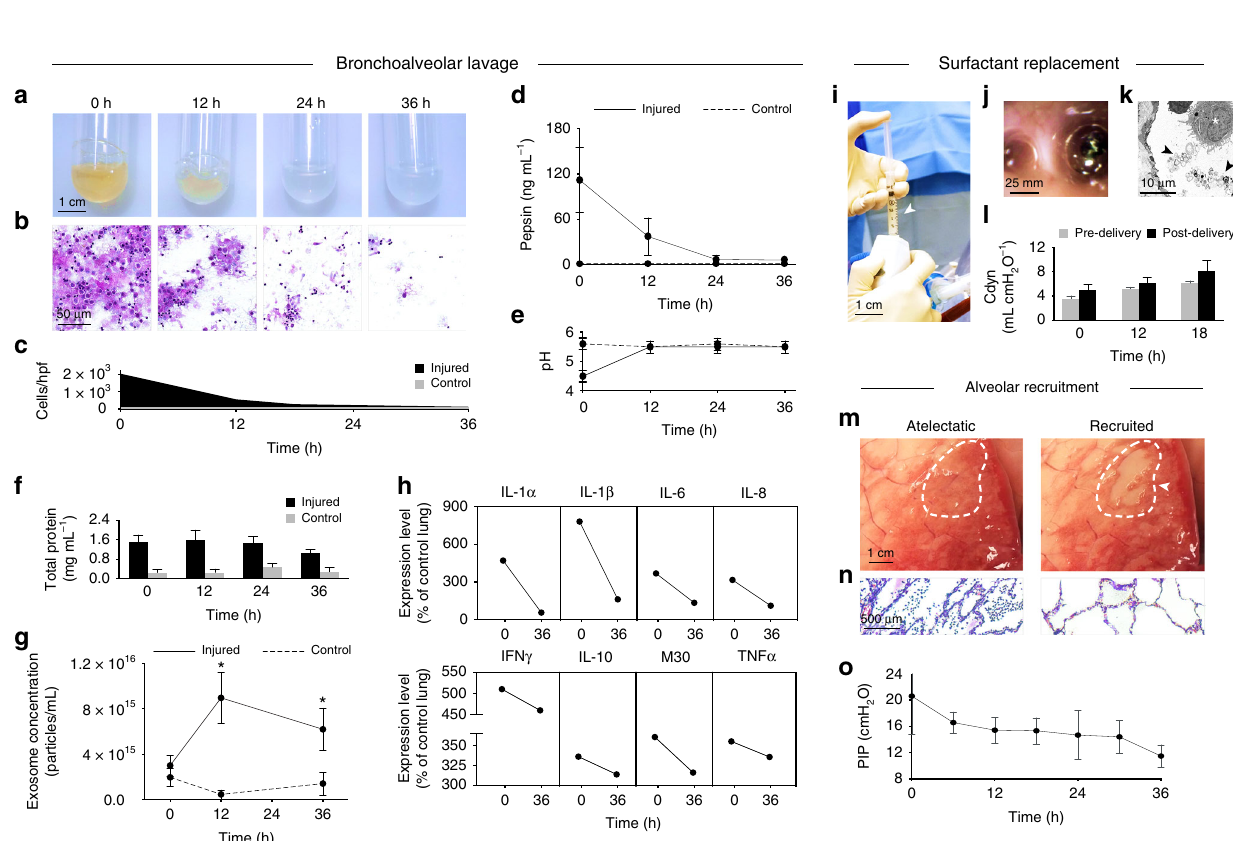
Fig. 3 Therapeutic interventions in injured lungs during cross-circulation. a Gross imaging of BAL fl uid samples collected from injured lungs over 36 h of cross-circulation. b Periodic acid-Schiff staining of BAL fl uid smears obtained from injured lungs. c Quanti fi cation of cells in BAL fl uid samples. d Pepsin concentration, e pH, f total protein, and g exosome concentration in BAL fl uid samples over 36 h of cross-circulation, Student ’ s t -test for Injured versus Control, * p < 0.001. h Mean cytokine expression levels in injured lungs, normalized as a percent of mean levels in control lungs, measured in BAL fl uid between initiation of cross-circulation (0 h) and conclusion of cross-circulation (36 h). Cytokine concentrations (mean ± standard deviation) throughout 36 h of cross-circulation in Supplementary Fig. 5c. Surfactant replacement: i Bronchoscopic delivery of therapeutic surfactant into injured lung (arrow). j Bronchoscopic image demonstrating therapeutic surfactant delivered into airways within the injured lung. k Transmission electron micrograph (TEM) demonstrating abundant surfactant (arrows) within alveoli following delivery. Alveolar macrophage (star) and adjacent lymphocyte observed within the same alveoli. l Dynamic compliance (Cdyn) of injured lungs pre- and post-delivery of therapeutic surfactant over the fi rst 18 h of cross-circulation. m Alveolar recruitment: before recruitment (atelectatic) and after recruitment (recruited). Arrow and dotted line indicates a region of recruitment. n Silver reticulin staining of collapsed consolidated lung, and recruited lung with open alveoli. o Peak inspiratory pressure (PIP) of injured lungs throughout 36 h of cross-circulation. All graphs represent data from n = 8 lungs. All values represent mean ± standard deviation from injured and control lungs had comparable mean diameters Following airway lavage, exogenous surfactant was delivered and size distributions (Supplementary Fig. 4d – f). In parallel, the via video bronchoscopy into each lobe of injured lungs (Fig. 3i, j; effect of interventional cross-circulation on the in fl ammatory Supplementary Fig. 8g), and was observed advancing distally response in injured lungs was analyzed by quanti fi cation of through the airway tree during positive pressure ventilation, cytokines in BAL fl uid. GM-CSF, IFN γ , IL-1 α , IL-1 β , IL-2, IL-4, consistent with the transport and deposition of liquid plugs IL-6, IL-8, IL-12, IL-18, M30, and TNF α all decreased over 36 h of through small airways 30,31 (Supplementary Movie 5). Transmis- sion electron microscopy con fi rmed the presence of abundant cross-circulation (Fig. 3h, Supplementary Table 9, Supplementary surfactant in distal airspaces (Fig. 3k; Supplementary Fig. 8h). Fig. 4c). NATURE COMMUNICATIONS| (2019) 10:1985